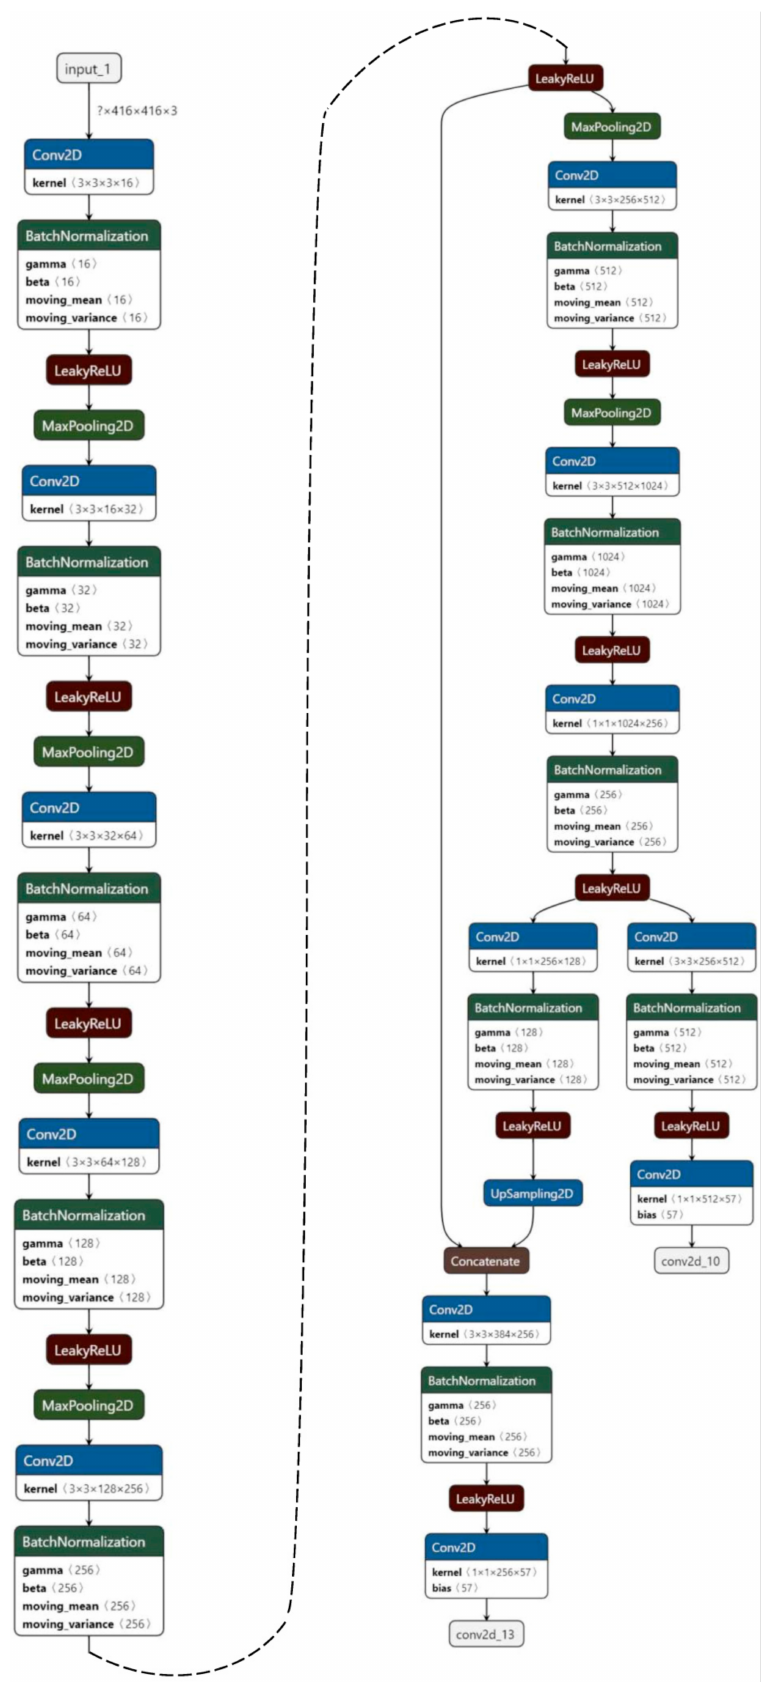
Figure 4. Object detection process flow